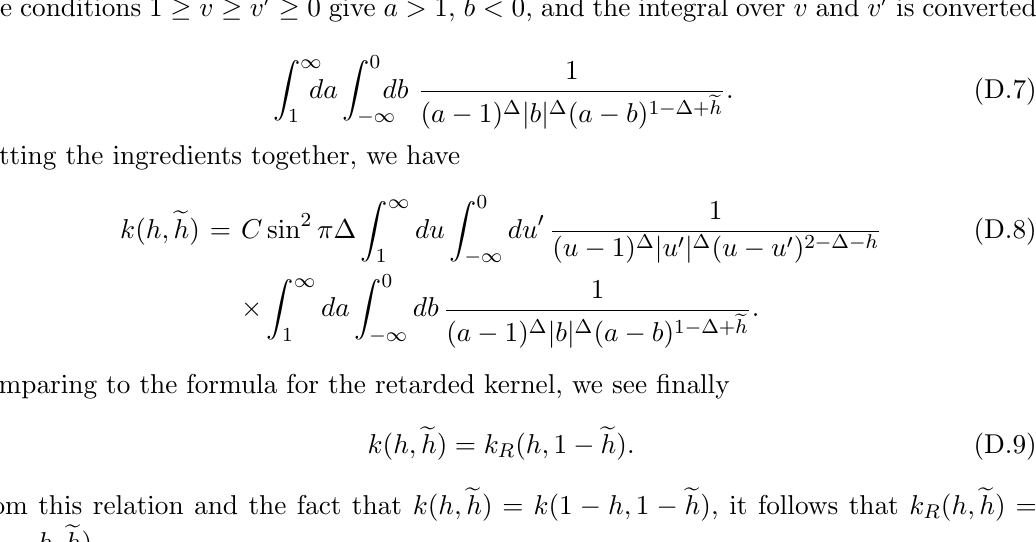
Figure 16 . (a) The u -plane with the indicated cuts starting at u = 1 + i(cid:15) and at u = u running parallel to the real axis. The integral on the real u axis can be deformed to an integral on the indicated contour. (b) The picture in the u 0 plane is a sort of mirror image, and the integration contour can be deformed from the real axis to the one